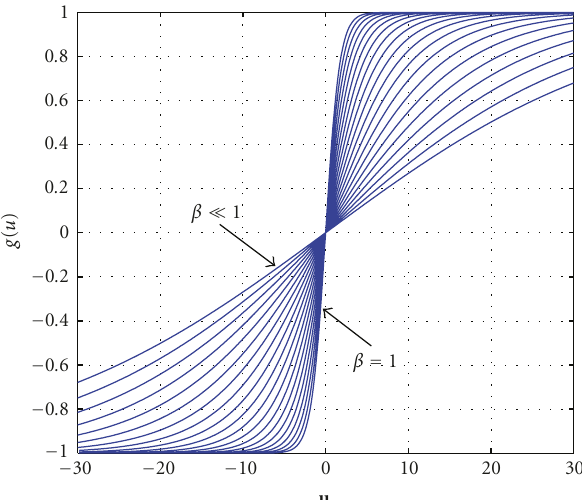
Figure 6: Simulated annealing on the bipolar decision function for Z = 20